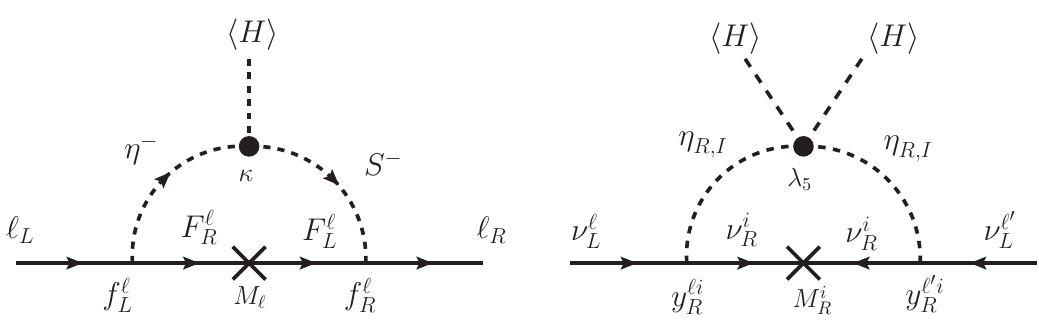
Figure 1 . One-loop diagram for generating the mass for charged leptons (left) and left-handed neutrinos (right).